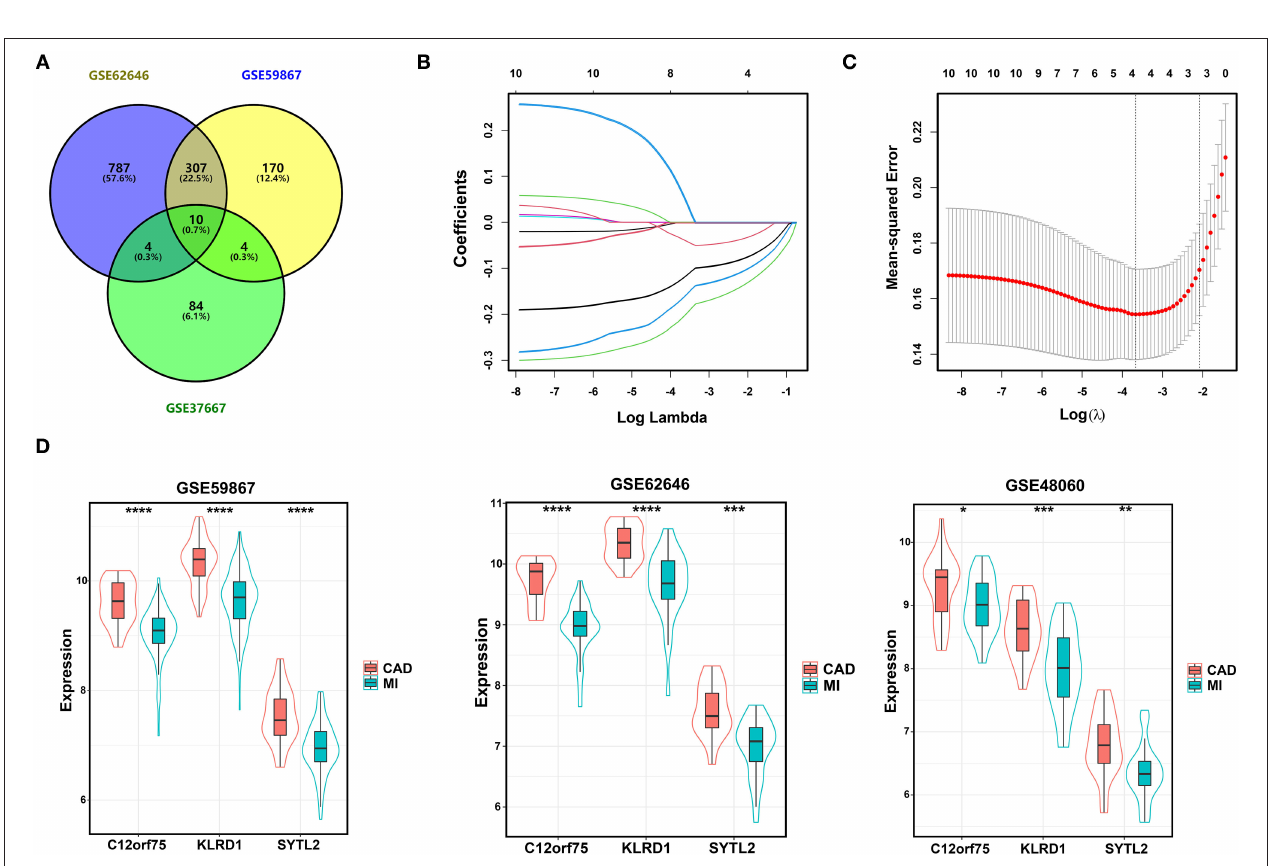
FIGURE 2 | of the GSE62646 dataset. In total, 1,108 MI-DEGs were identified from the GSE62646 dataset between the MI and CAD PBMC samples, including 593 downregulated and 515 upregulated genes. (C) Volcano plot (left) and heatmap (right) of the GSE37667 dataset. In total, 102 SD-DEGs were identified from the